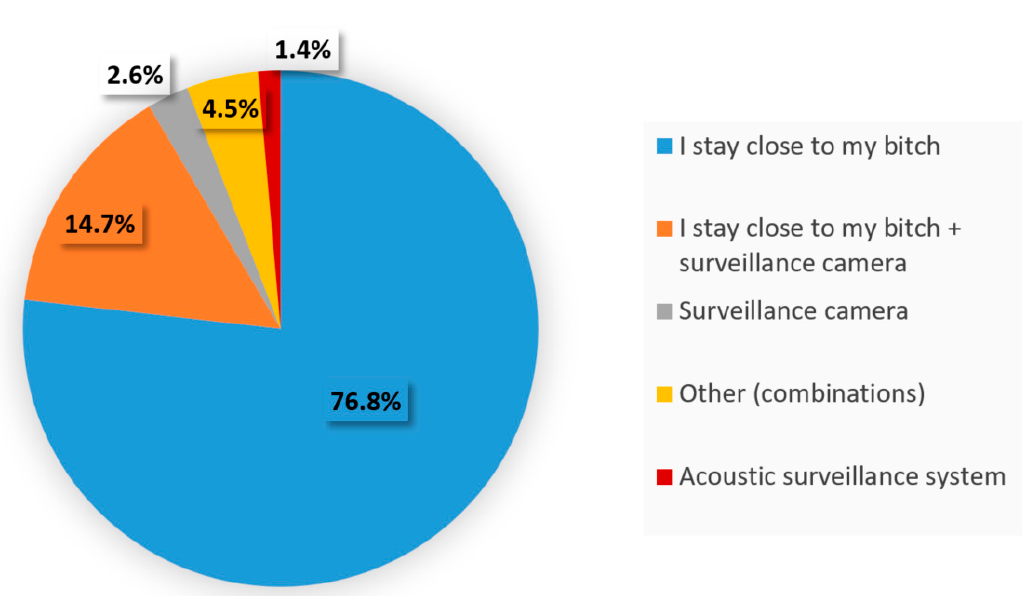
Figure 7. Methods of surveillance of the bitch at whelping time.